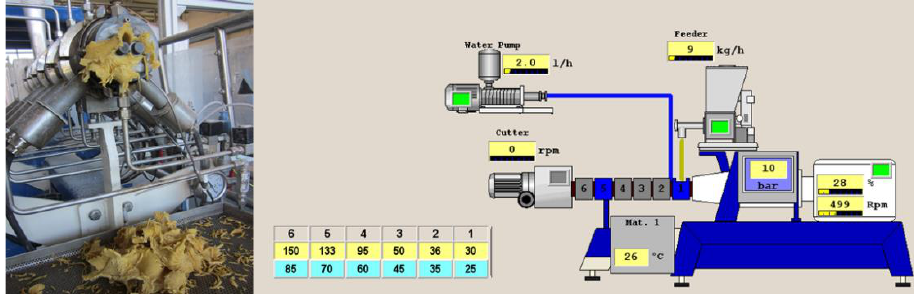
Figure 1. Twin–screw extruder ( left ) and display of process parameter monitoring ( right